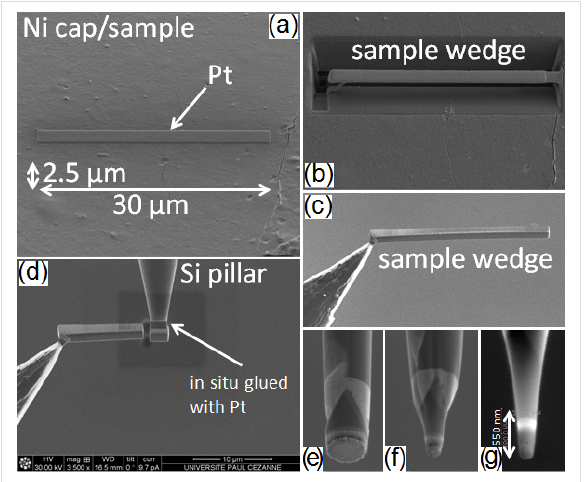
Figure 1: SEM images acquired during APT sample preparation in a dual-beam FIB process. The image sequence (a to f) corresponds to the chronological steps required for the fabrication of an APT